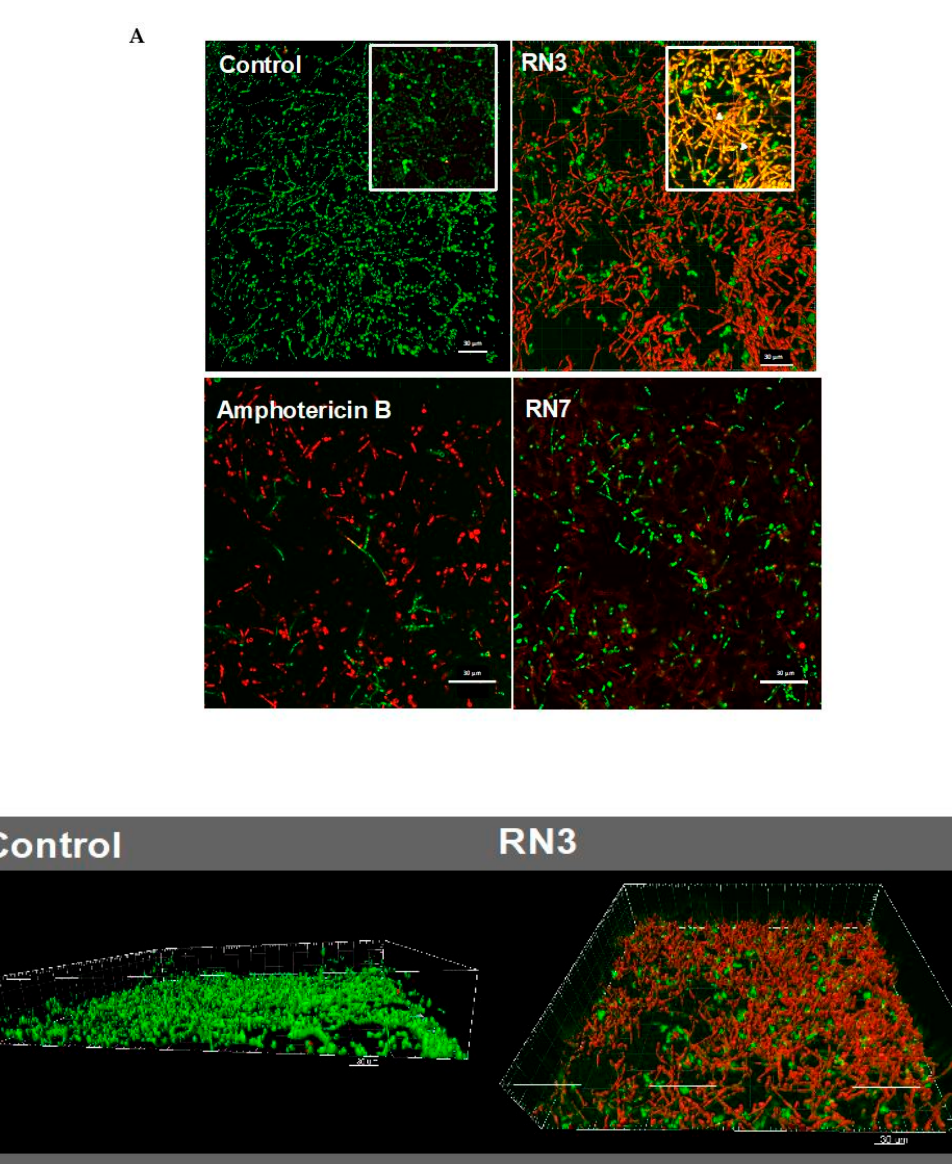
Figure 5. ( A ) Visualization by confocal microscopy of mature C. albicans biofilms treated with 20 µ M of RN3, RN7 and amphotericin B. Live / Dead stain corresponds to green and red labelled cells, respectively. Right-up detailed zone in control and RN3 images correspond to the overlapping of SYTO9 and PI, showing an increment of hypha formation and reduction of hyphal-viability. ( B ) 3D reconstruction and projections using the IMARIS software ® of control and treated biofilm with RN3 peptide. The percentage of viability in the biofilm was reduced to 18% ± 5. Bars: 30 μ m.